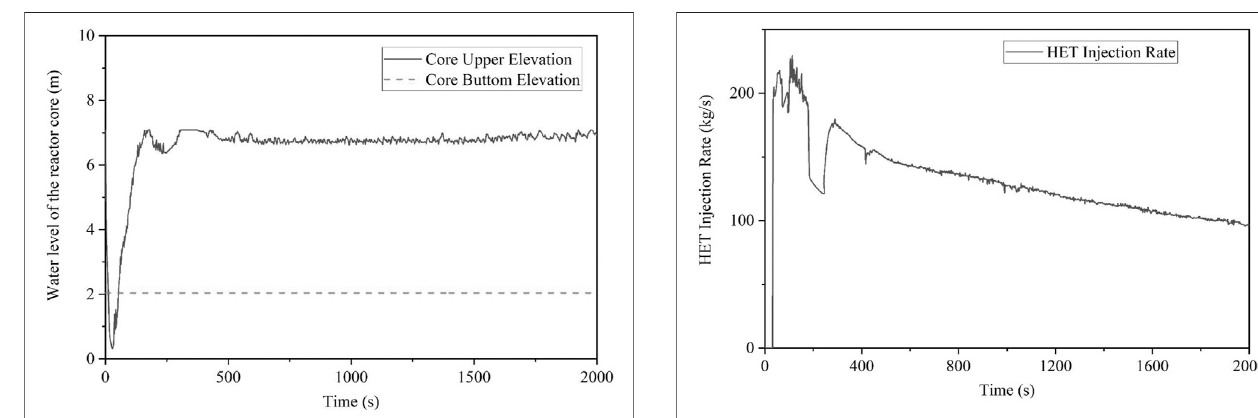
FIGURE 8 | Double-ended CL LBLOCA reactor core water level.